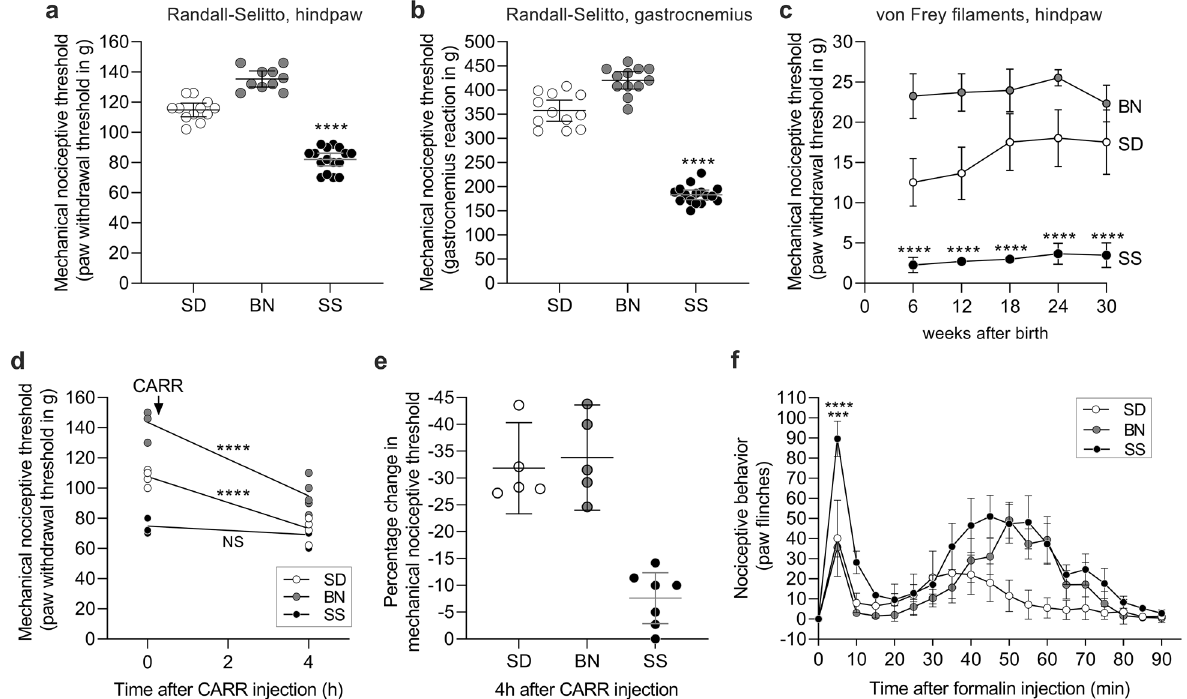
Figure 1. SS rats exhibit higher nociceptive sensitivity. Mechanical nociceptive thresholds of untreated SS (full symbols), SD (empty symbols) and BN (gray symbols) rats were determined on the dorsum of the hindpaw ( a ) and the gastrocnemius muscle ( b ) by the Randall-Selitto test, or in the plantar surface, over the course of 30 weeks, starting at the 6th week post birth, using von Frey filaments ( c ). In all tests, SS rats showed significantly lower nociceptive thresholds than SD and BN rats (panels a and b, respectively: F (2,35) = 164.7 and F (2,37) = 293.2, **** p < 0.0001 for both strains, one-way ANOVA followed by Bonferroni posttest; ( c ): F (2,29) = 171.7, **** p < 0.0001 for both strains, two-way repeated measures ANOVA followed by Bonferroni posttest). ( d ): SS, SD and BN rats received an i.d. injection of CARR (1%) on the dorsum of the hindpaw, and were compared to the baseline, paired Student’s t-test) and BN (t 4 = 8.595, p = 0.0010) groups (F (2,14) = 110.0, **** p < 0.0001 when the change in the thresholds induced by CARR in SS rats was compared to those in